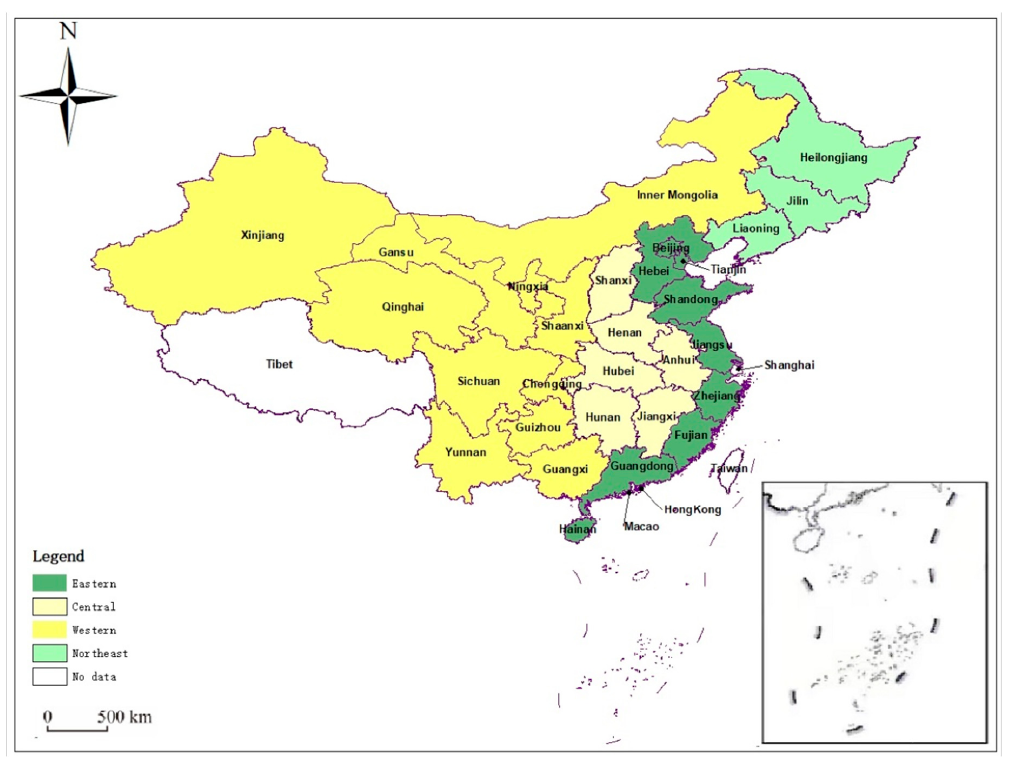
Figure 5. Four main regions of industrial transfer in